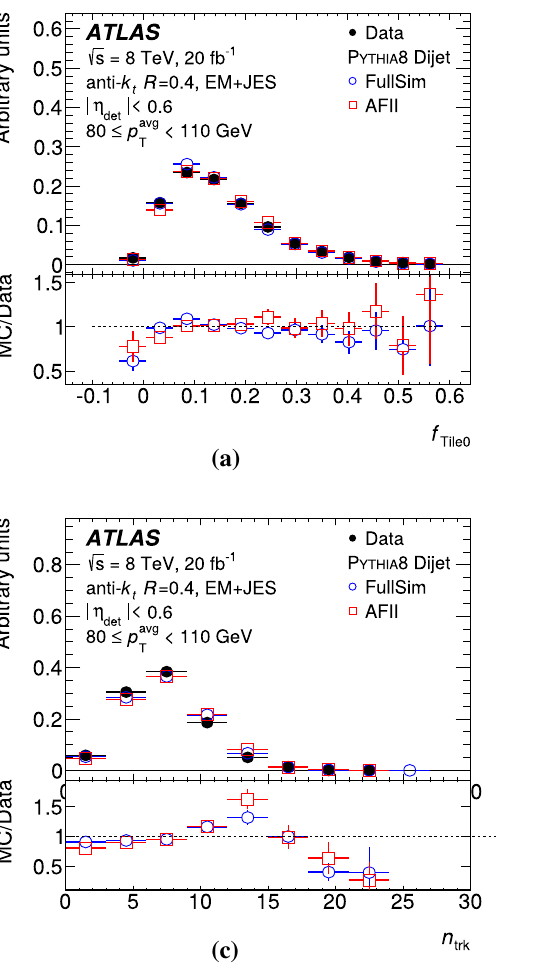
Fig. 6 Normalized distributions of f Tile0 , f LAr3 , n trk , and W trk for jets | η det | < 0 . 6 in dijet events with 80GeV < p avg data (filled circles) and Pythia8 MC simulation with both full (empty circles) and fast (empty squares) detector simulation. All jets are recon-